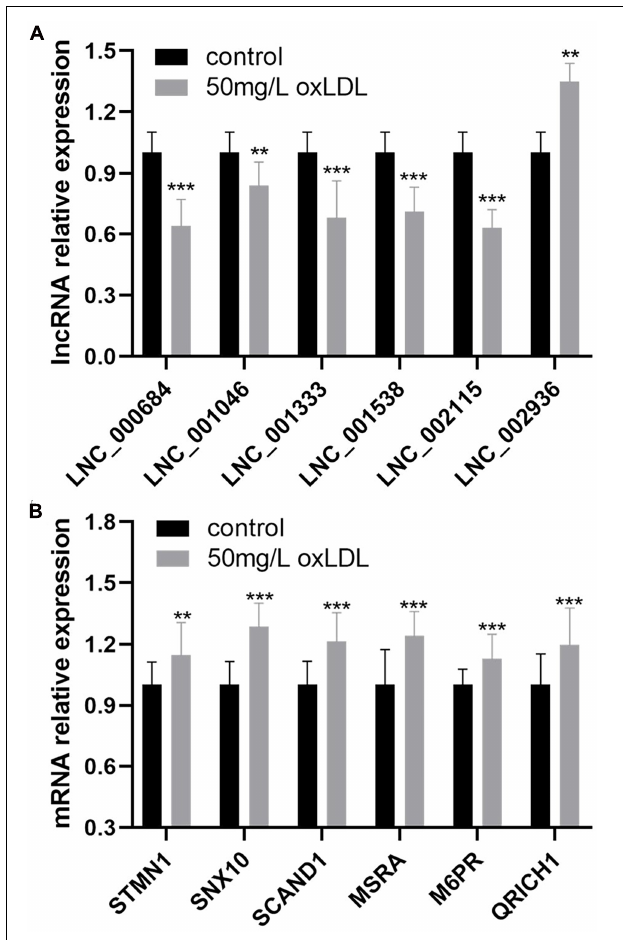
FIGURE 7 | The relative expression of six lncRNAs and coexpressed mRNAs in human coronary artery smooth muscle cells (HCASMCs) induced with oxidized low-density lipoprotein (ox-LDL). (A) LNC_000684, LNC_001046, LNC_001333, LNC_001538, and LNC_002115 were downregulated while LNC_002936 was upregulated in the proliferation and migration models of HCASMCs induced with 50 mg/L ox-LDL for 24 h. (B) STMN1, SNX10, SCAND1, MSRA, M6PR, and QRICH1 were upregulated in the proliferation and migration models of HCASMCs induced with 50 mg/L ox-LDL for 24 h. ** p < 0.01, *** p <